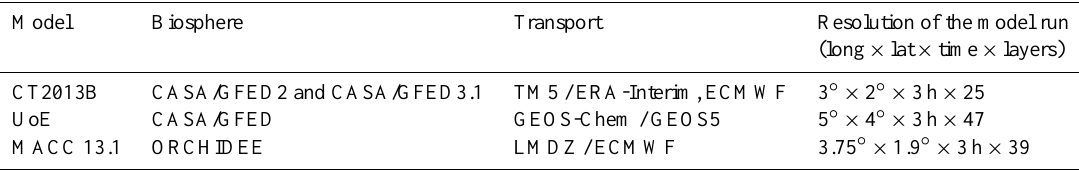
Figure 1. TCCON sites used for GOSAT evaluation in this study. Table 1. Models used in the evaluation of the GOSAT seasonal cycle.